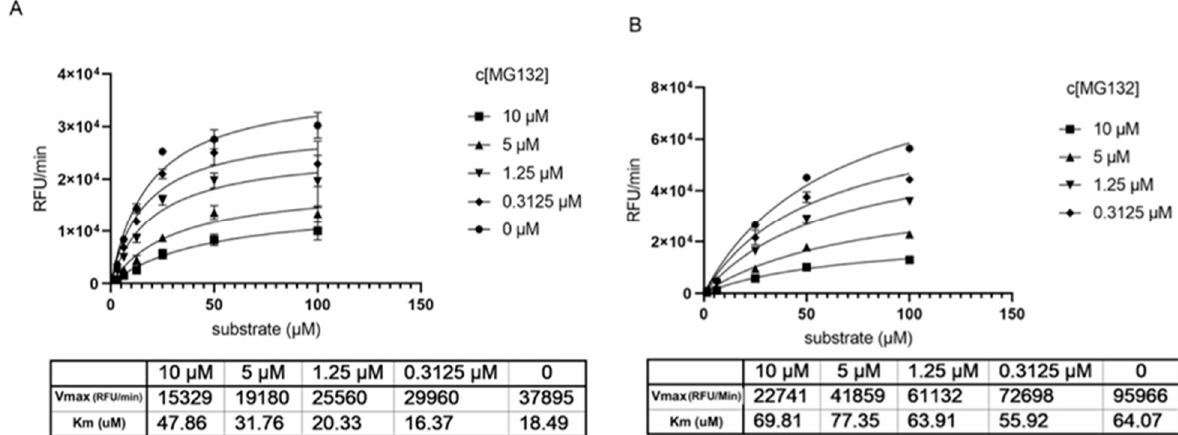
Figure 3. Determination of key kinetic parameters of Mpro in presence of MG-132. ( A ) without preincubation of Mpro with MG-132. ( B ) after 1 h preincubation of Mpro with MG-132.